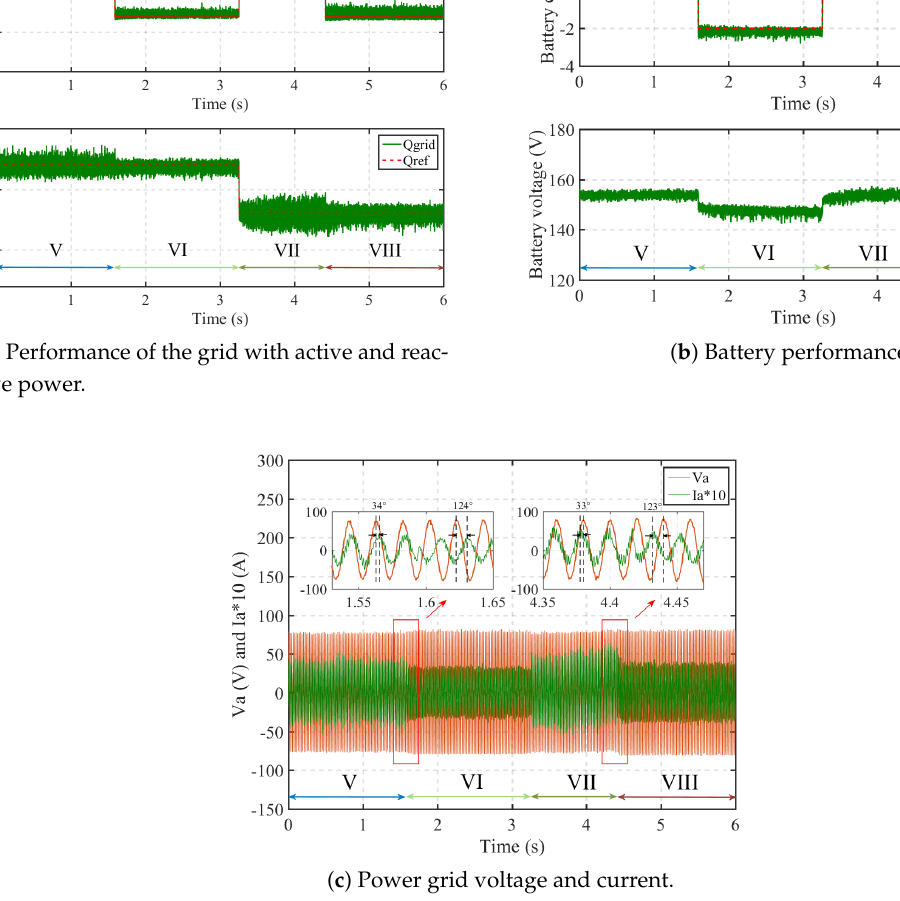
Figure 12. Experimental results in Quadrants V, VI, VII, and